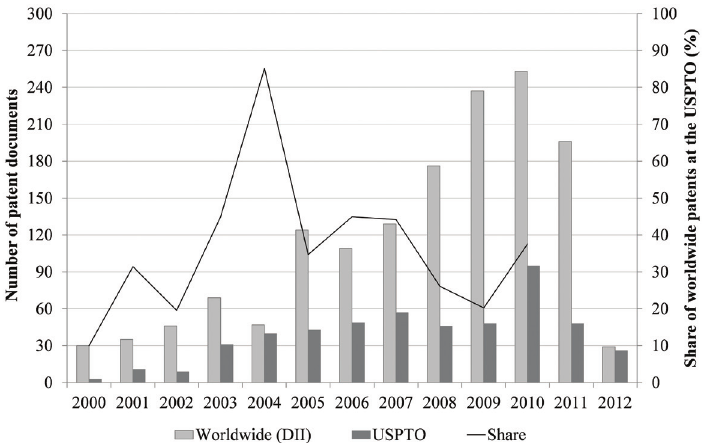
Figure 1. Annual number of patent documents in nanocellulose worldwide and at the USPTO and the relation between them from 2000 to 2010. Source: USPTO and